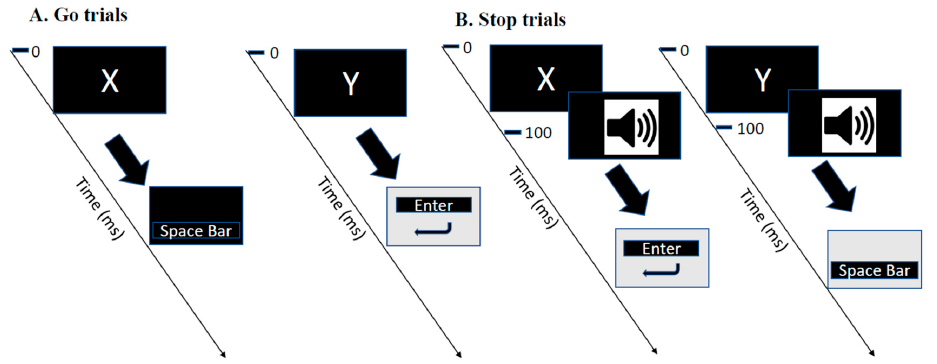
Figure 2. Experimental protocol for cognitive fatigue task. ( A ). Participants were asked to respond to a letter X and Y pressing the “Space bar button” and “Enter button,” respectively. ( B ). On a subset of trials, this was followed by an auditory stop signal, which signaled participants to reverse their response. ms,